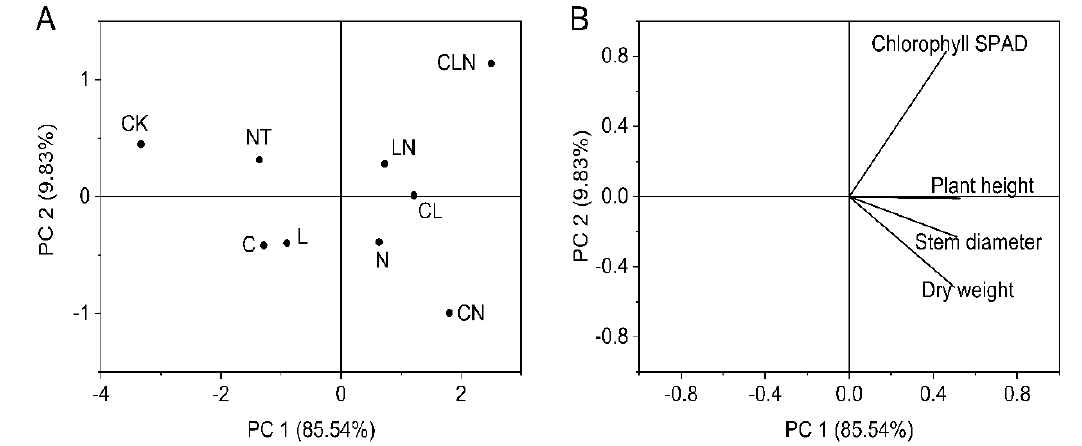
Figure 4. Principal component analysis of stem ( A ) and leaf growth ( B ) in seeding stage in Papaya. Whereas CK—control without the use of bio-pesticides, C—use of 0.50 g L − 1 Chitosan, L—use of 10.00 g L − 1 Lentinan, N—use of 0.05 g L − 1 Ningnanmycin, CL—Chitosan plus Lentinan, CN—